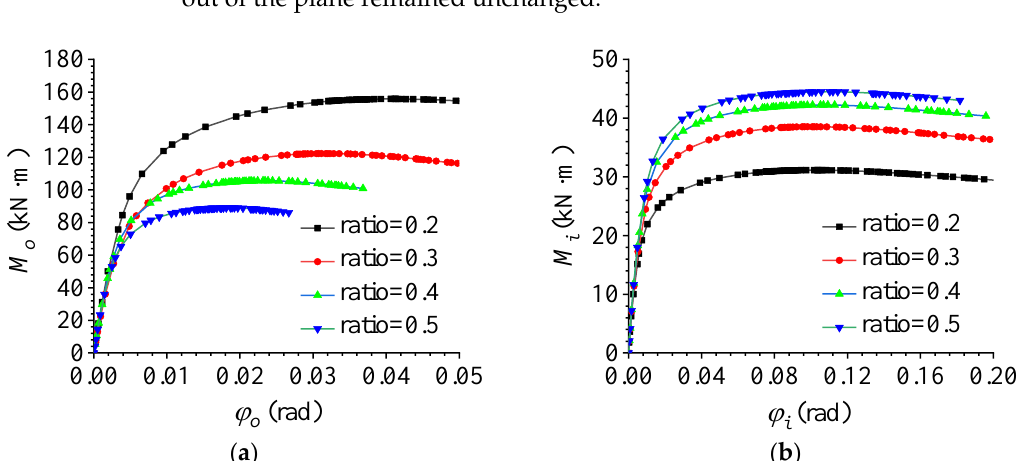
Figure 20. Effect of the ratio of in-plane and out-of-plane bending moments. ( a ) Out-of-plane M–φ curve; ( b ) in-plane M–φ curve.